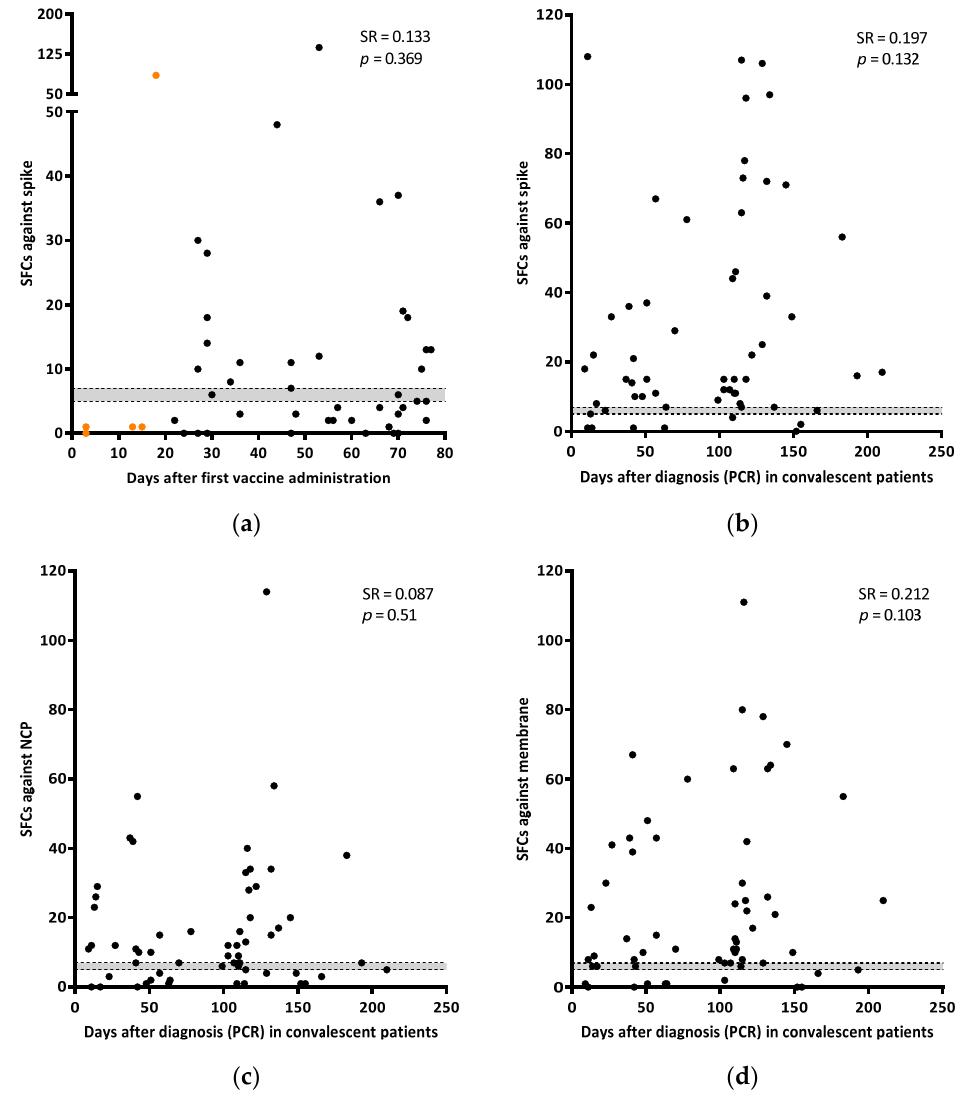
Figure 2. Correlation of the IFN- γ response against spike (SFCs) with days after the first dose of the vaccine administration ( a ). Orange dots are samples from individuals with only one dose. Correlation of the IFN- γ response (SFCs) in spike ( b ), NCP ( c ), and membrane ( d ) with days after diagnosis (PCR) in convalescent patients. Grey area shows borderline results. Correlations were calculated using the two-tailed non-parametric Spearman